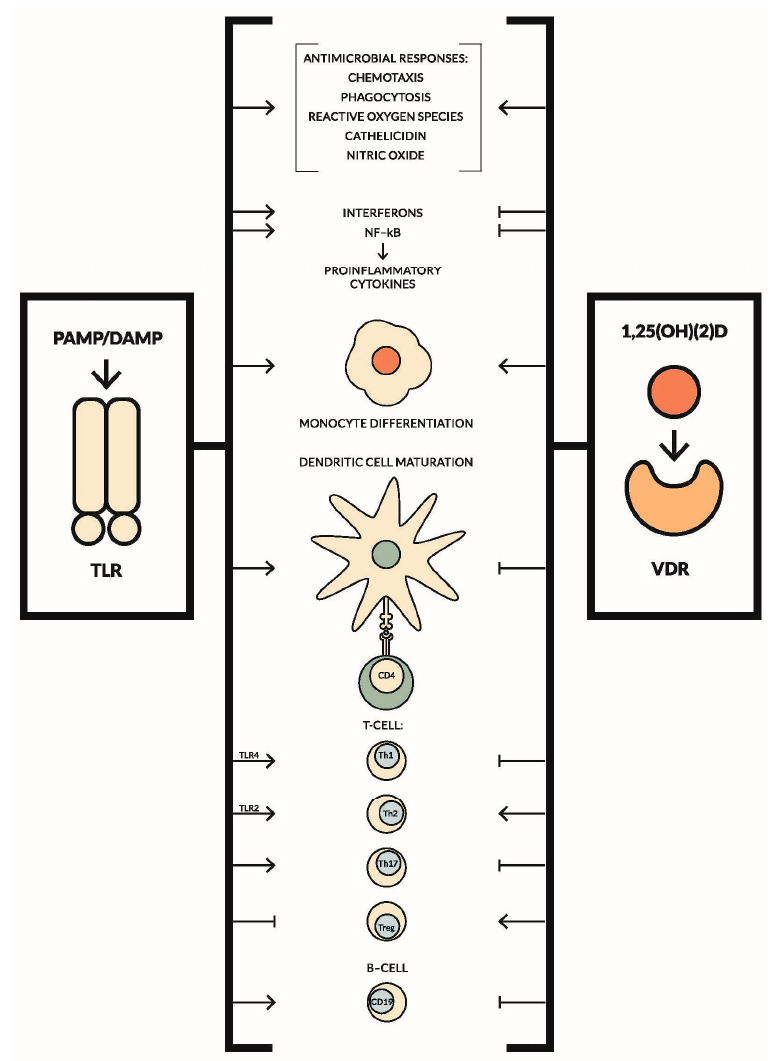
Figure 1. The role of toll-like receptors and vitamin D in innate and adaptive immune responses.